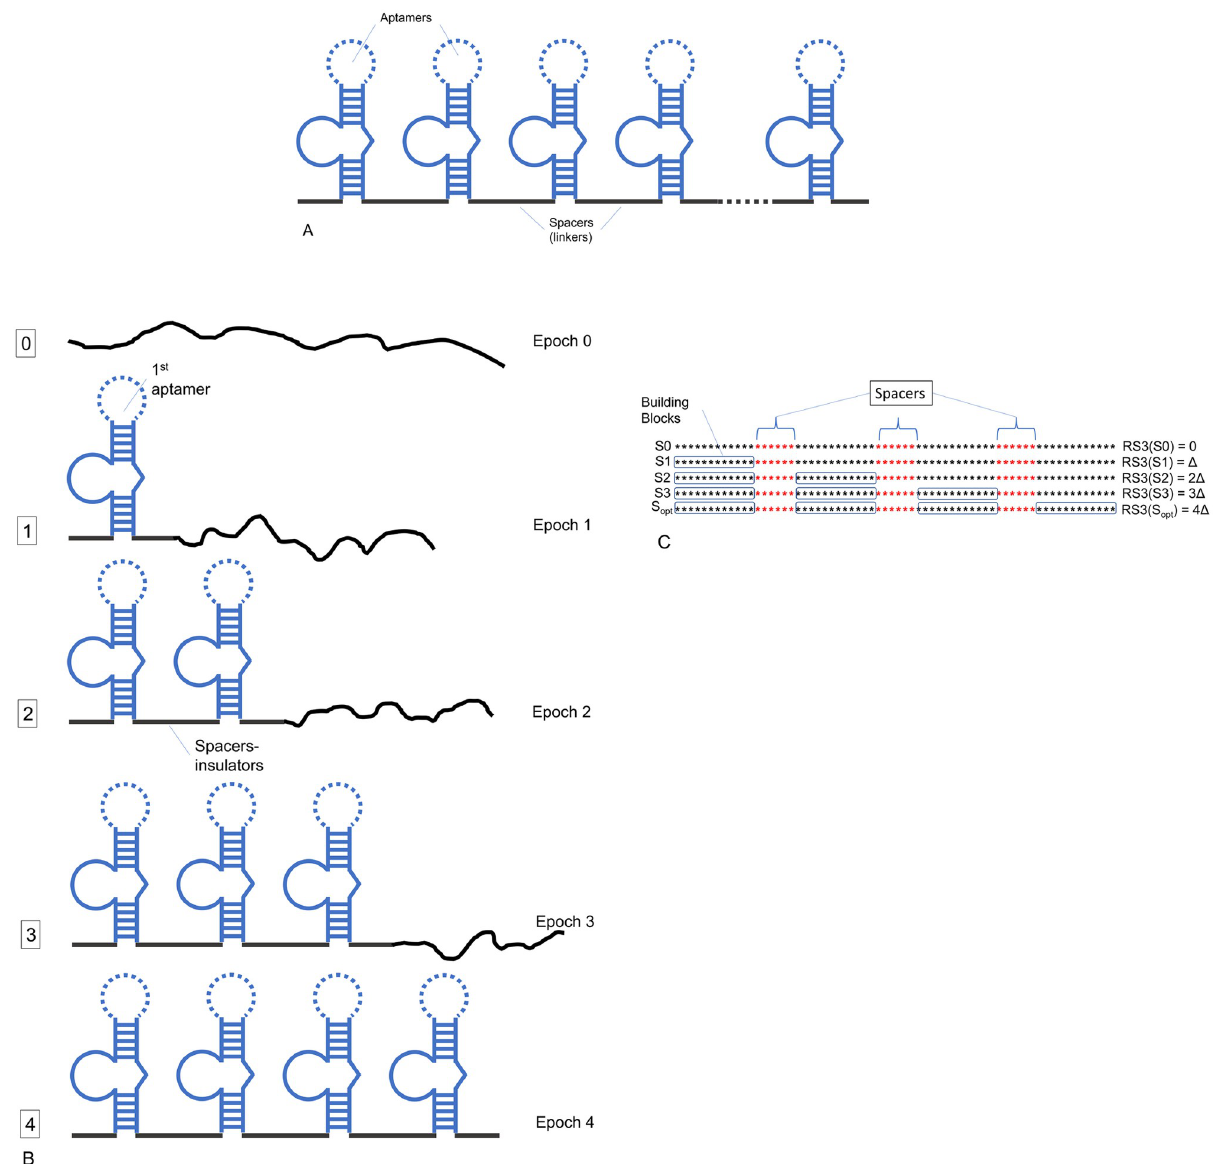
Fig 3. Molecular biological illustration of the idea of evolutionary search with BioRS. (A) General idea of the battery of (identical) modules as it is formulated by Babiskin & Smolke [82]. (B) Our scheme of sequential search from scratch of a tetrameric aptamer. (C) Search scheme for a classic RS function with 4 BBs (above). Domains (BBs) separated by insulating spacers of predetermined length are searched sequentially from left to right. Delta is an increment of fitness level for each correctly found aptamer (BB). See text and legend to Fig 2 for the detailed description of an aptamer